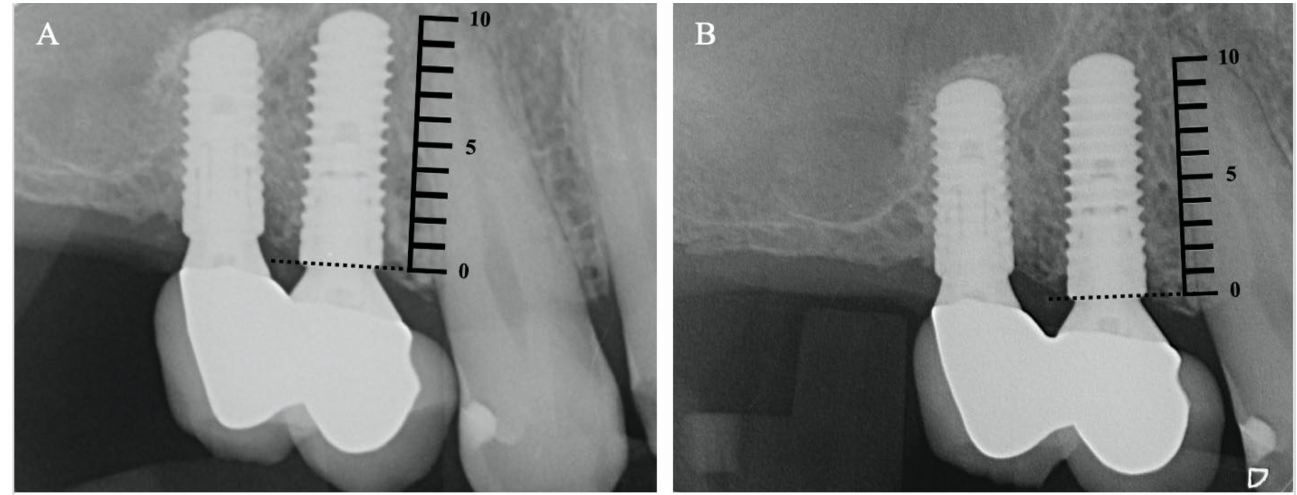
Figure 2. Representative X-rays of an implant of the platform switching group, ( A ). Prosthetic baseline, ( B ).